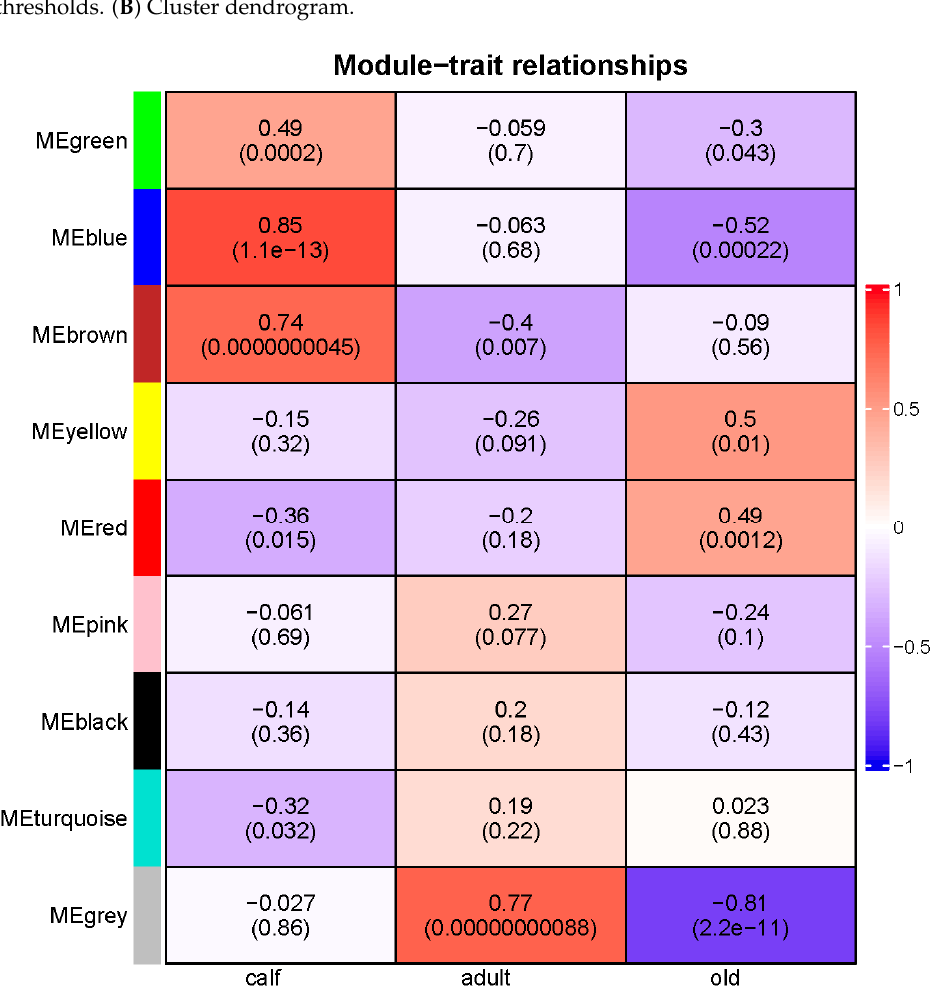
Figure 2. Scale independence and mean connectivity of co-expression network. ( A ) Screening of soft thresholds. ( B ) Cluster dendrogram.